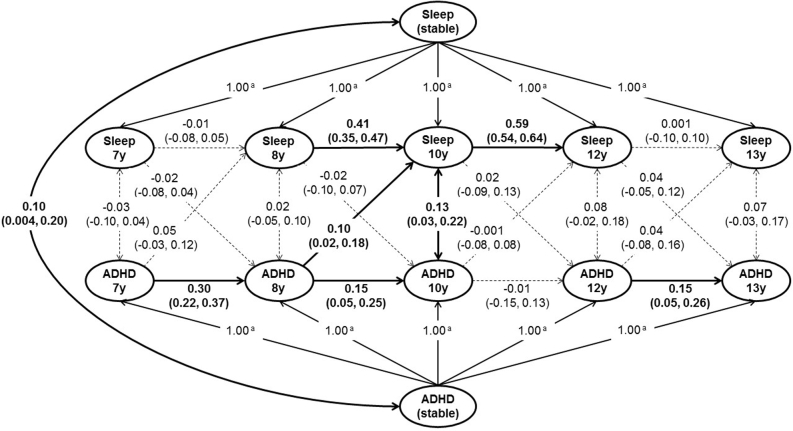
Cross-lagged analysis between attention-deficit/hyperactivity disorder (ADHD) and sleep disturbance in the Quebec Longitudinal Study of Child Development. Random-intercepts cross-lagged panel model of ADHD total score and sleep disturbance from ages 7 to 13 years in the Quebec Longitudinal Study of Child Development (n = 1601). Standardized estimates (95% confidence intervals) are presented. Solid lines represent statistical significance (p < .05), whereas dashed lines represent nonsignificance (p > .05). Model fit: root mean square error of approximation = 0.04; comparative fit index = 0.98; Tucker-Lewis index = 0.96; standardized root mean square residual = 0.04. aPathways constrained to 1.00 to isolate between-person factor.